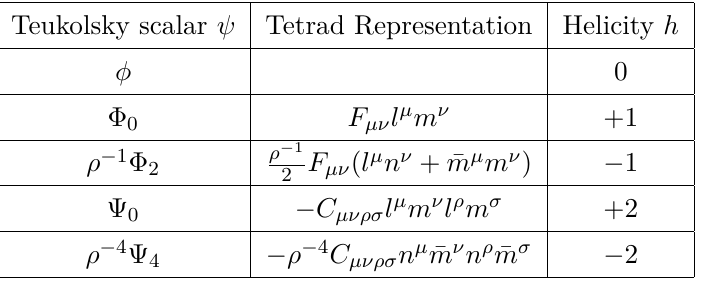
Table 1. Teukolsky scalar for perturbations of helicity h . Here F µν and C µνρσ correspond to the Faraday and Weyl tensors respectively, whereas the spin coefficient ρ − 1 = ( r − ia cos θ )